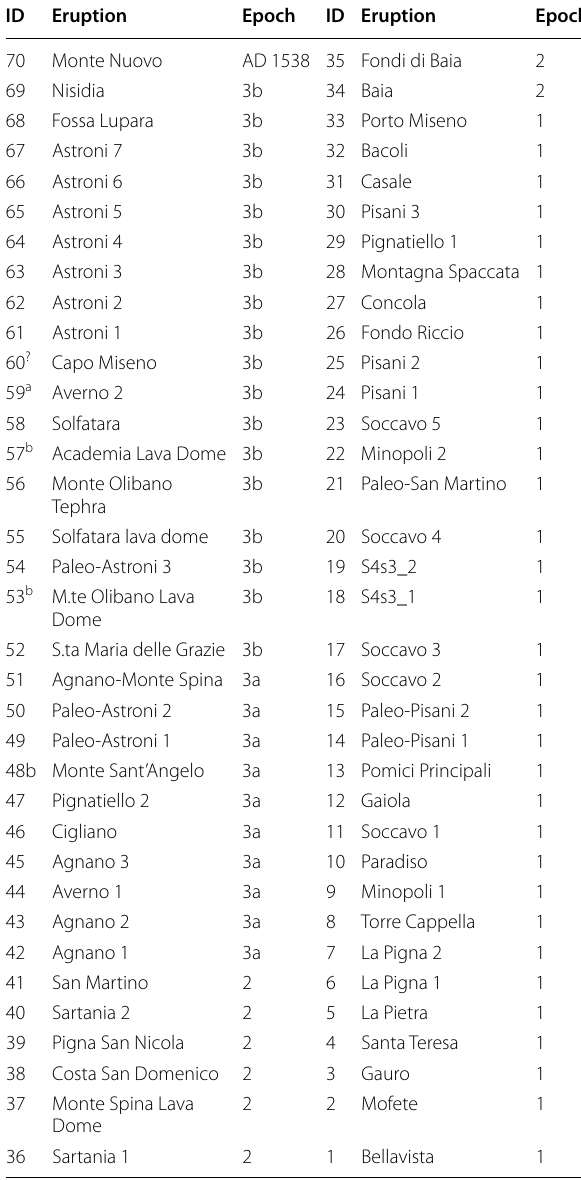
Table 1 Eruptions at the CFC in the last 15 ky. Modified from Bevilacqua et al.